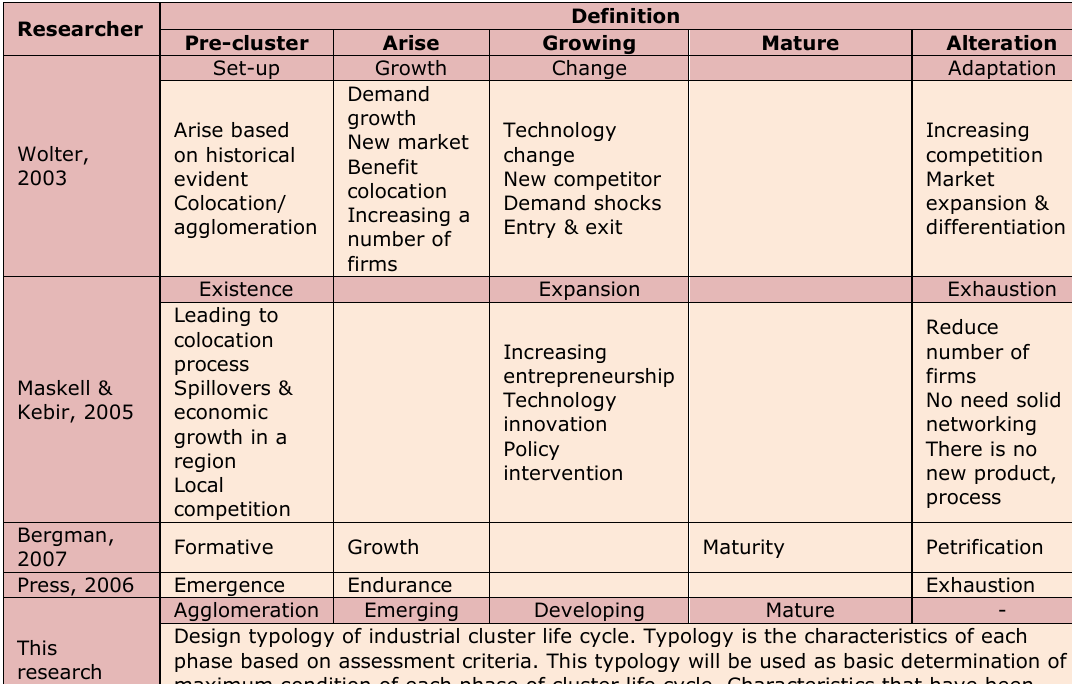
Table 1. Definition and characteristics of industrial cluster life